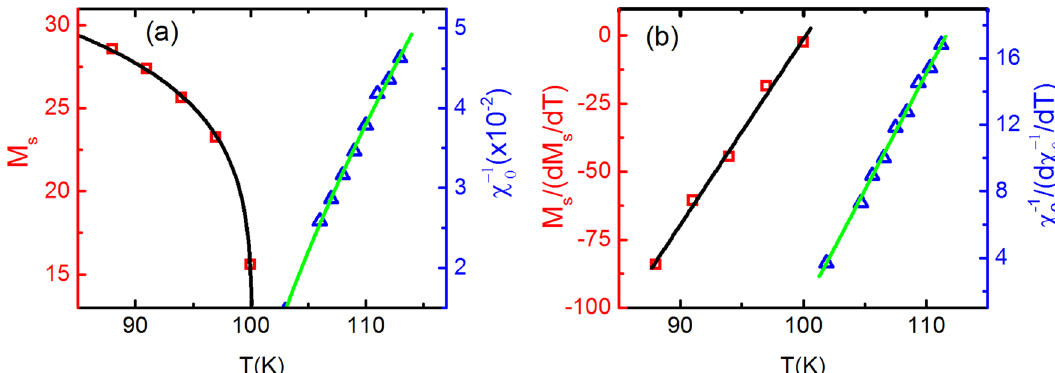
Figure 6. ( a ) The square symbol represents the M S versus T plot and the solid curve is its fitting with Eq. (5) 1 which results into β = 0.148. The triangle symbol represents the χ − 0 versus T plot while solid curve passing through it, is its fitting with Eq. (6) which yields γ = 0.761. ( b ) The square symbol is the M S /( dM S / dT ) versus T plot and the solid curve is its fitting with Eq. (10) which results into β = 0.147. The triangle is the χ − 1 0 /( d χ − 1 0 / dT ) versus T plot while solid curve is its fitting with Eq. (11) which yields γ =